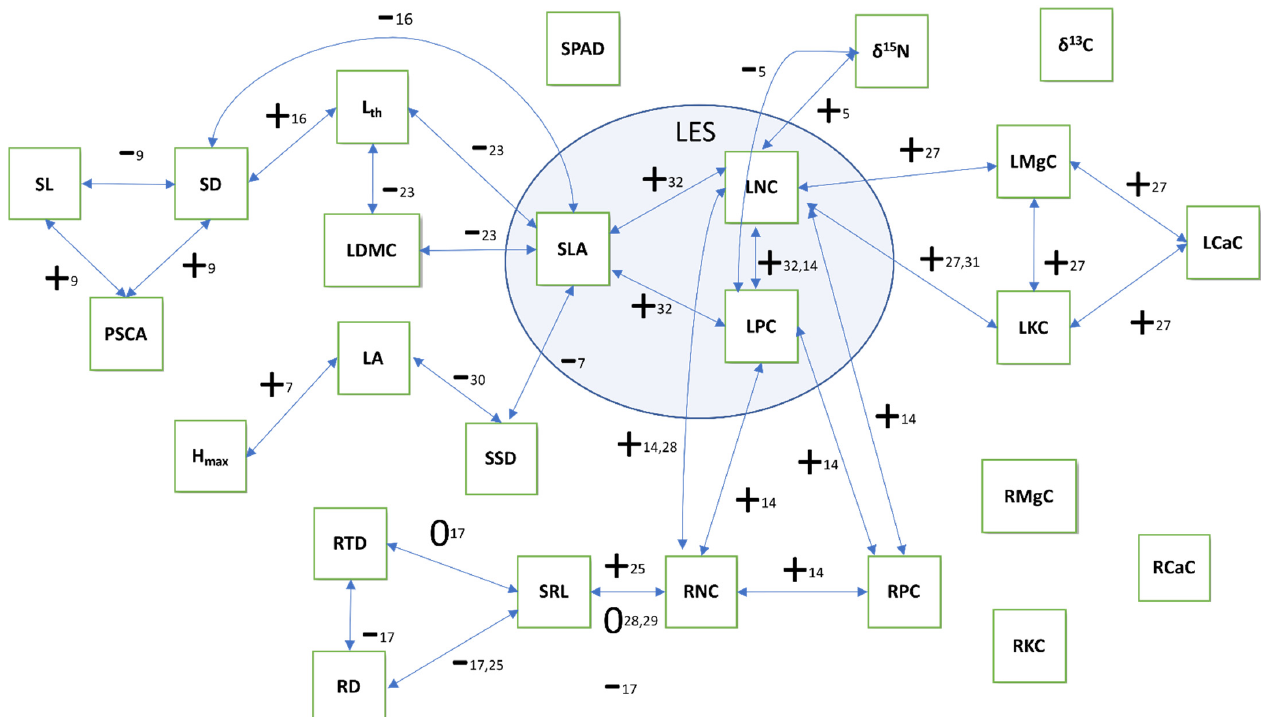
Figure 2. Expectations regarding correlations between the studied traits. Trait abbreviations are explained in Table 1. The traits in the inner circle are part of the classical leaf economics spectrum (LES). Arrows indicate reported relationships between traits in the literature. “+”: positive relationship, “ − ”: negative relationship, “0”: no relationship. Numbers refer to publications that established these links, and which are listed in the supplement. For a full list of traits and abbreviations, see Table 1.